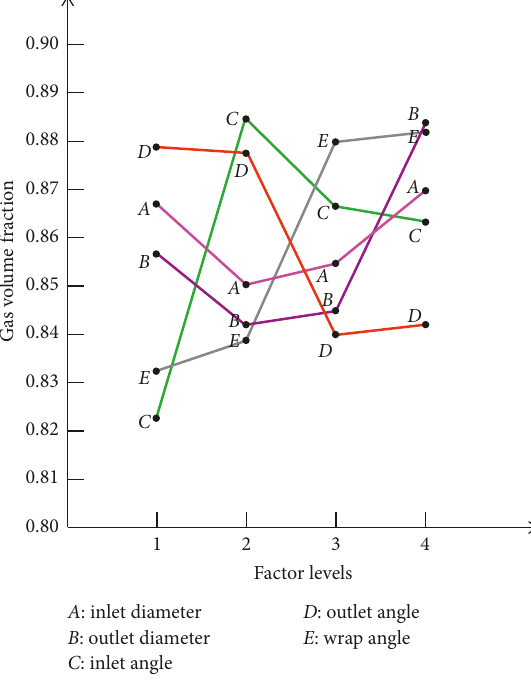
Figure 9: Influence trend of each parameter on gas volume fraction.